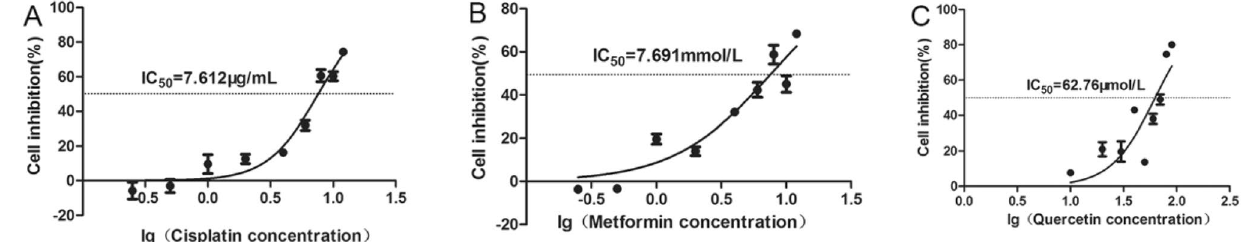
Figure 1. lg drug concentration-cell inhibition rate curve of different drugs on Sune-1 cells. ( A ) cisplatin, ( B) metformin, ( C)